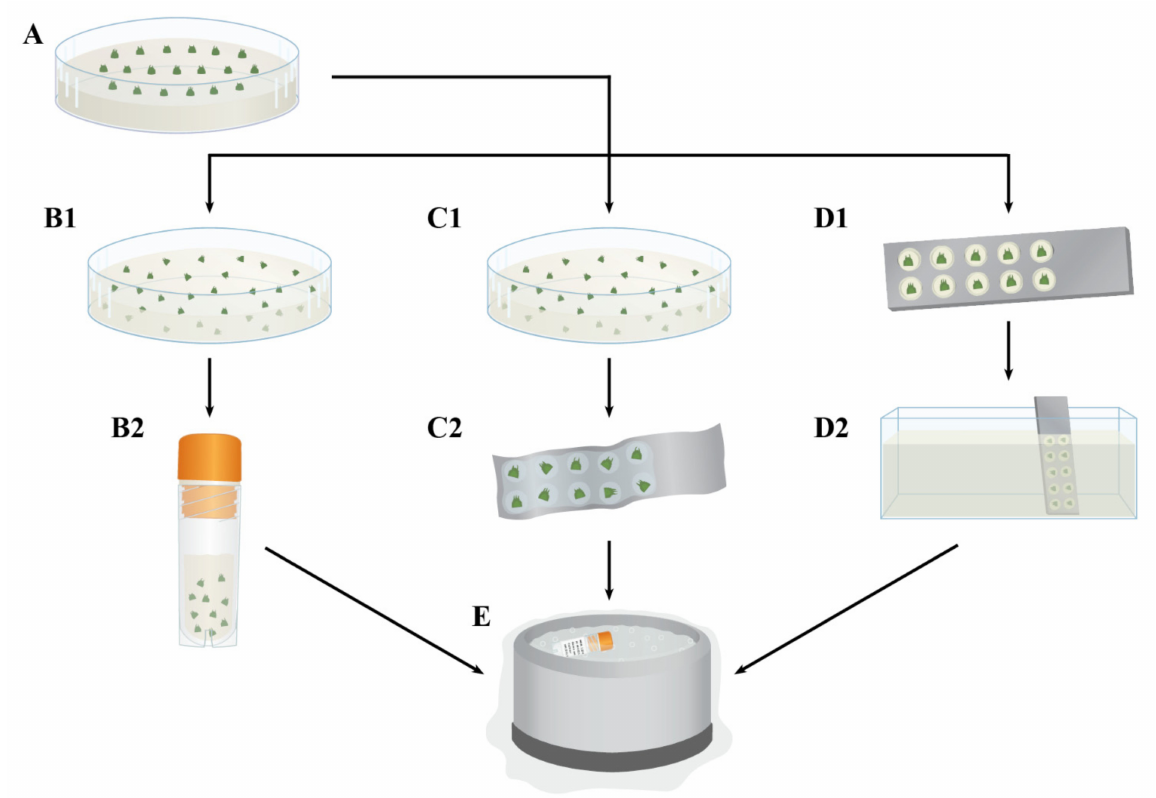
Figure 2. Major steps of grapevine shoot tip cryopreservation by vitrification ( B1 , B2 ; [31,32]), droplet-vitrification ( C1 , C2 ; [35–37]) and V cryo-plate ( D1 , D2 ; [76]). Shoot tips incubated in the preculture medium ( A ), osmoprotected in loading solution ( B1 , C1 ) or first attached to cryo-plates using calcium alginate solution ( D1 ) after which cryo-plates with shoot tips attached are osmoprotected in loading solution ( D2 ). Osmoprotected shoot tips either attached to cryo-plate (V cryo-plate) or not (vitrification and droplet- vitrification) are dehydrated in PVS2 ( D2 ; V cryo-plate). Shoot tips are transferred to cryovials containing a small volume (1–1.5 mL) of fresh vitrification solution ( B2 ; vitrification) or a thin layer of PVS2 placed on sterile aluminum foil strips ( C2 ; droplet-vitrification) or cryo-plates followed by liquid nitrogen exposure ( E